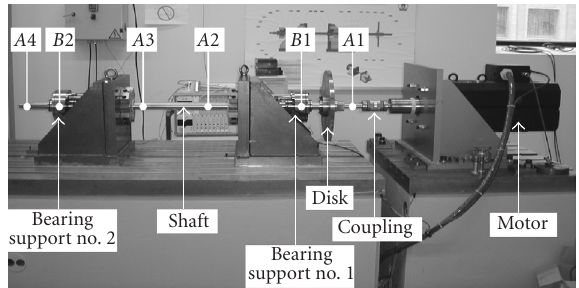
Figure 1: Description of the test rotor.